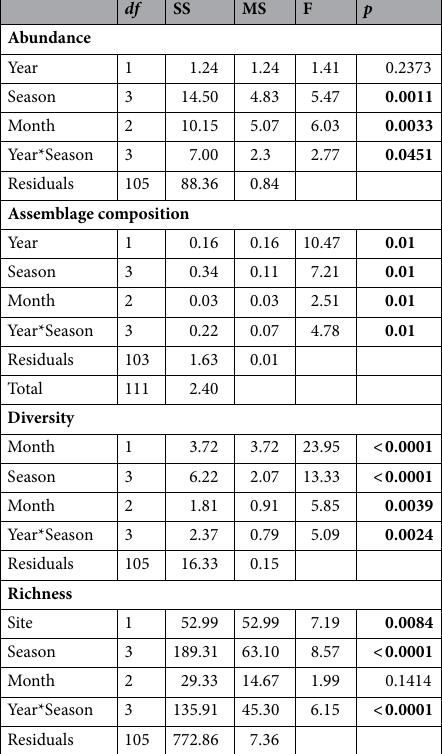
Table 2. Results of 3-way analyses of variance and permutational analysis of variance to compare the differences in recruit assemblage abundance (total number of recruits), composition (number of recruits per taxa), diversity (Shannon–Wiener Index S-W), and richness (number of species/taxa) between months, seasons, and years. F for statistic, significant results ( p < 0.05) are in bold.